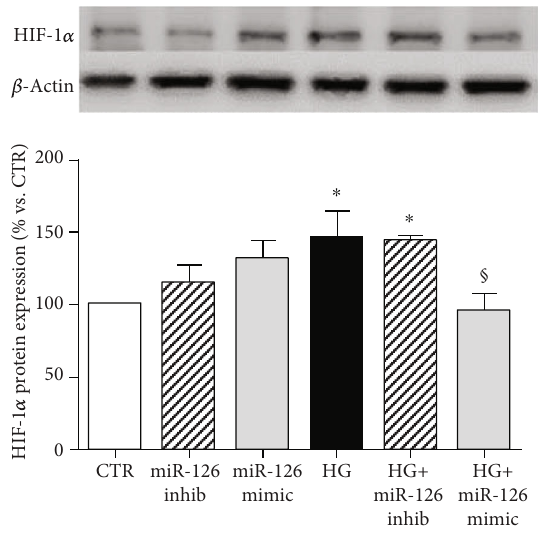
Figure 2: Western blot analysis of HIF-1 α protein levels in ARPE- 19 cells cultured for 24 hours in standard medium (CTR), silencing (inhib) and upregulating (mimic) miR-126 in control condition and in presence of high glucose (HG). Representative Western blot analysis and quanti fi cation of densitometries of Western blot band. Data were expressed as mean ± SEM of fold induction relative to β -actin of three independent experiments ( n = 3 ). ∗ p < 0 : 05 vs. CTR; $ p < 0 : 05 HG+mimic vs.